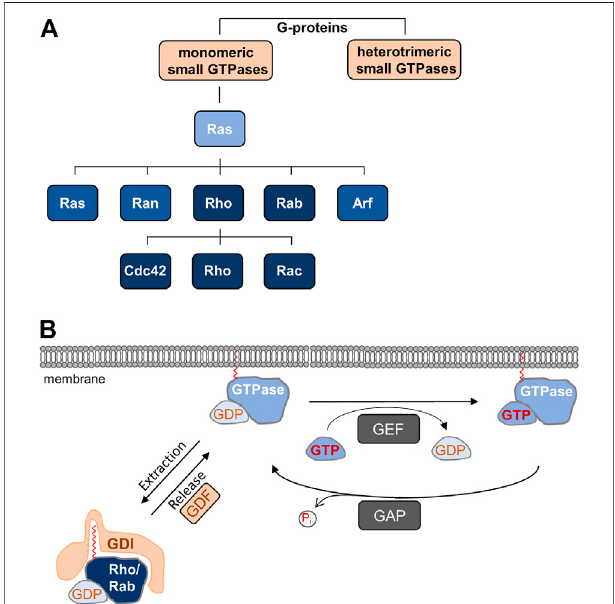
FIGURE 1 | (A) Monomeric small GTPases belong to G-proteins. Ras is the founding member of the Ras superfamily of monomeric small GTPases, which is divided in fi ve families. The Rho family is further subdivided into the Cdc42, Rho, and Rac subfamilies. (B) Cyclic regulation of monomeric small GTPases. Monomeric GTPases are anchored in membranes through prenylgroups. Local guanine nucleotideexchange factors (GEFs) catalyze the exchange of GDP by GTP resulting in the active GTPase, whereas local GTPase-activating proteins (GAPs) hydrolyze GTP to release inorganic phosphate (P i ), which results in the inactivation of the GTPase. Rho and Rab family GTPases are sequestered in the GDP-bound, inactive form to the cytosol by guanine nucleotide dissociation inhibitors (GDIs), which mask the prenyl groups required for membrane insertion. Through the activities of GDI displacement factors (GDFs), inactive GTPases are released from GDI- inhibition allowing membrane localization.